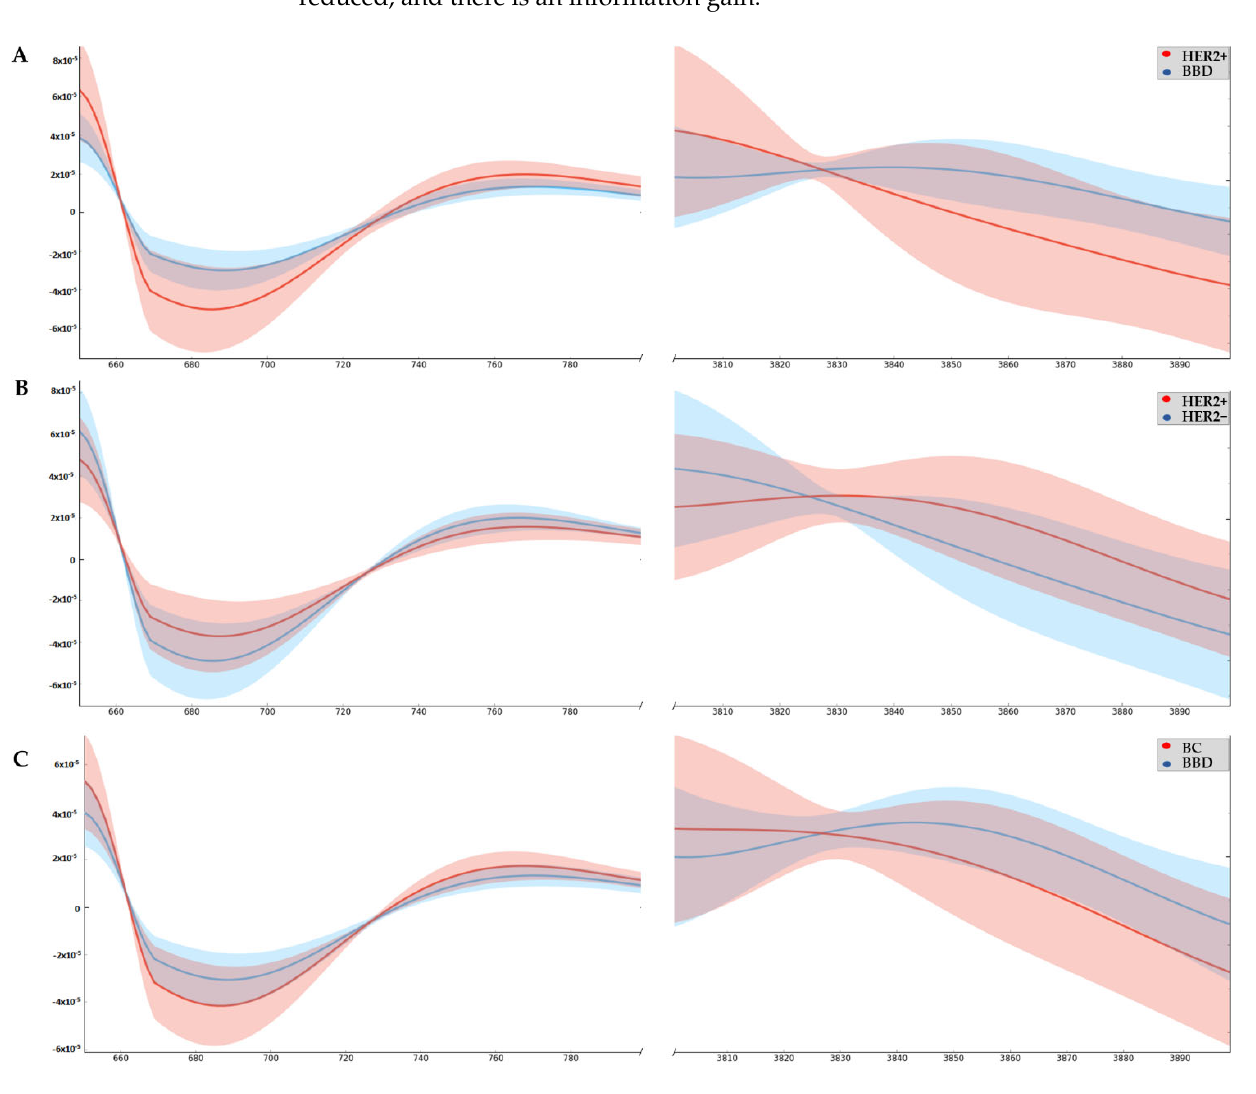
Table 2. Assignments and comparison between second derivative serological ATR ‐ FTIR spectra of